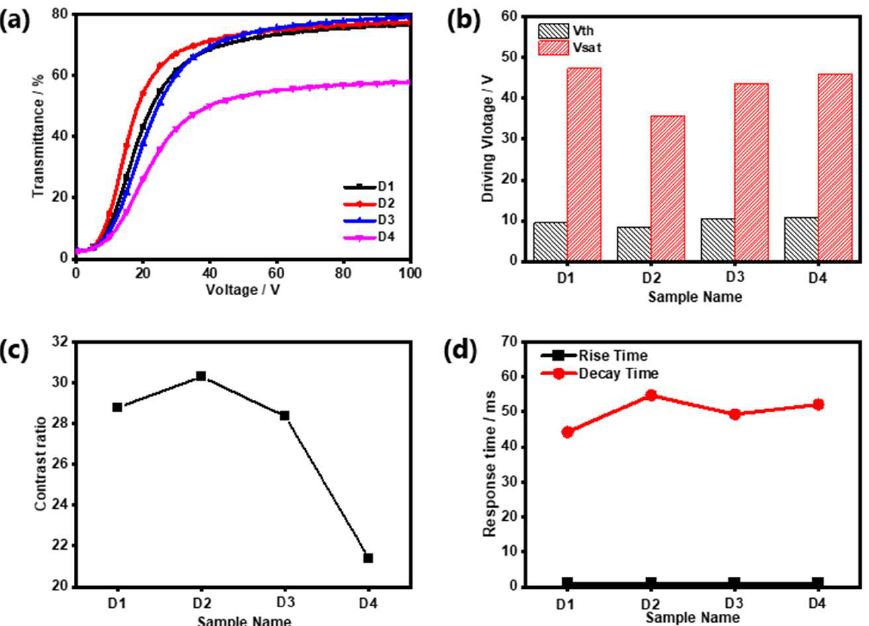
Figure 9. ( a ) Transmittance as a function of applied voltage (at 100 Hz frequency); ( b ) bar graph for threshold voltages ( V th ) and saturations voltage ( V sat ); ( c ) contrast ratio ( CR ) and ( d ) response time of Samples D1–D4.